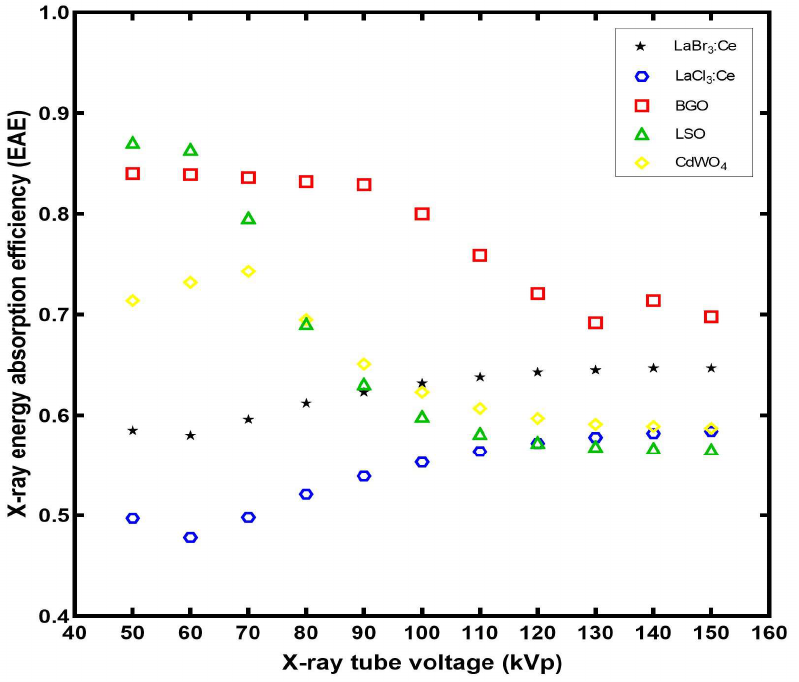
Figure 2. EAE of LaBr 3 :Ce, LaCl 3 :Ce, BGO, LSO and CdWO 4 single crystals.